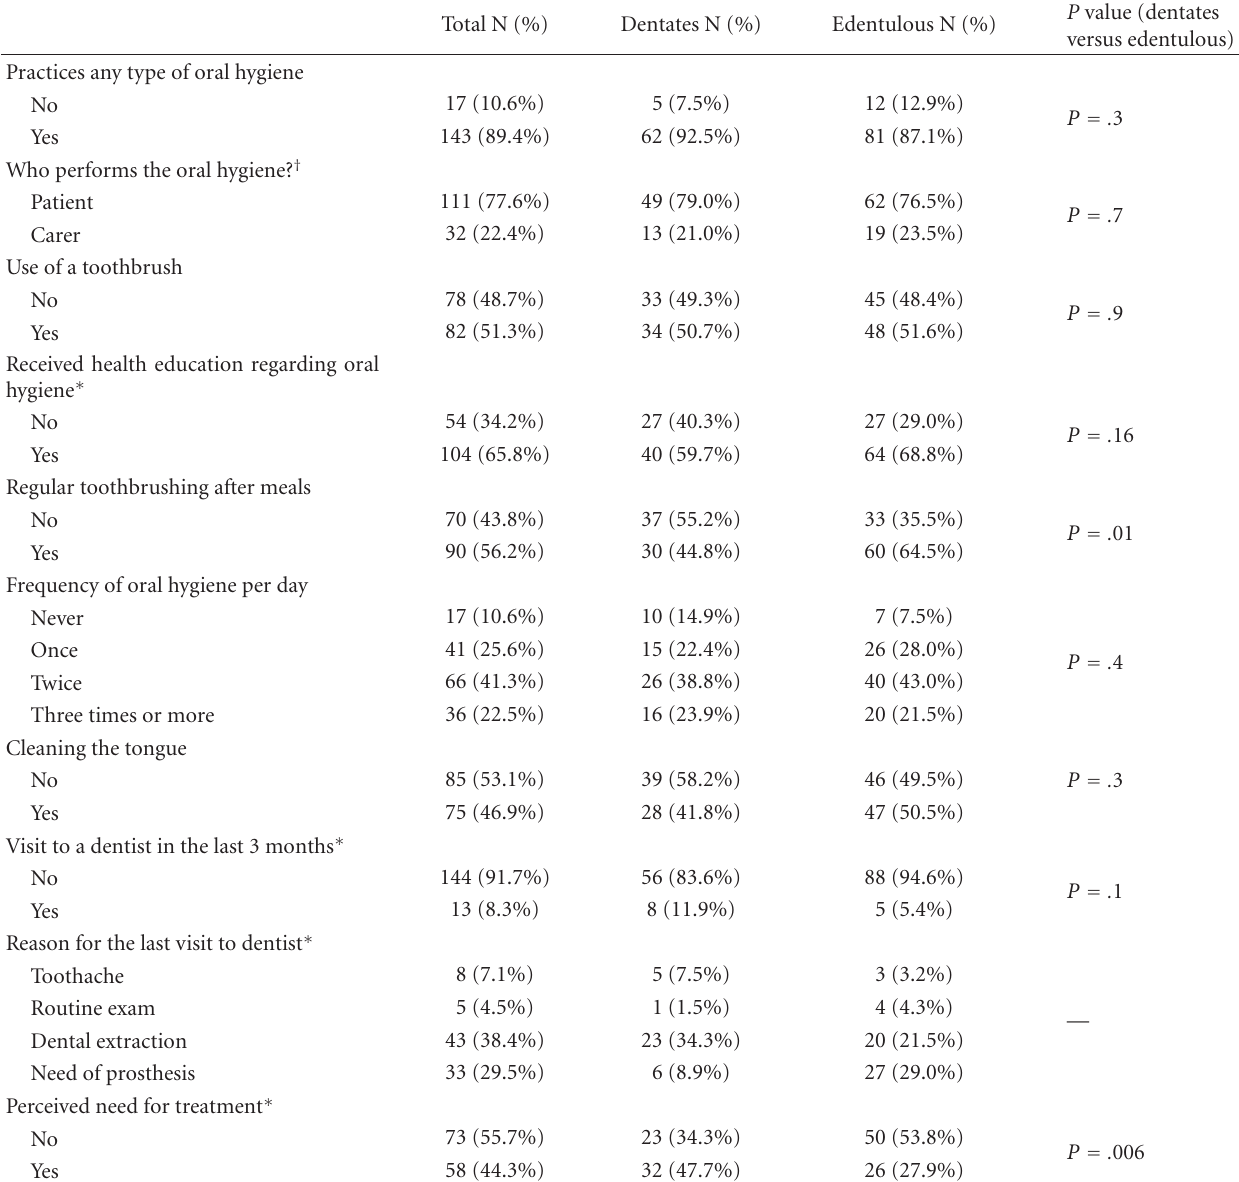
Table 2: Oral hygiene practices of institutionalized older people in northeast Brazil ( n =